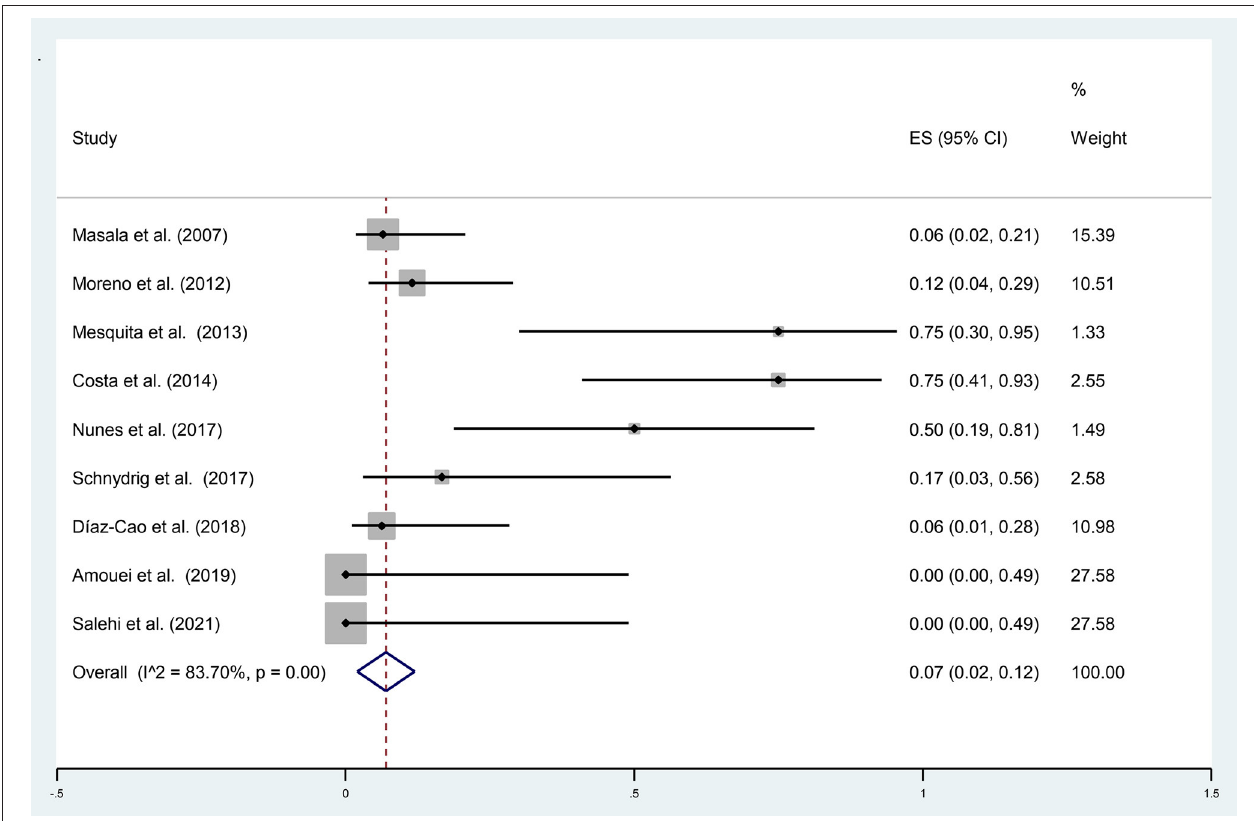
FIGURE 3 | The prevalence of N. caninum infection in the aborted fetuses of goats using molecular methods.